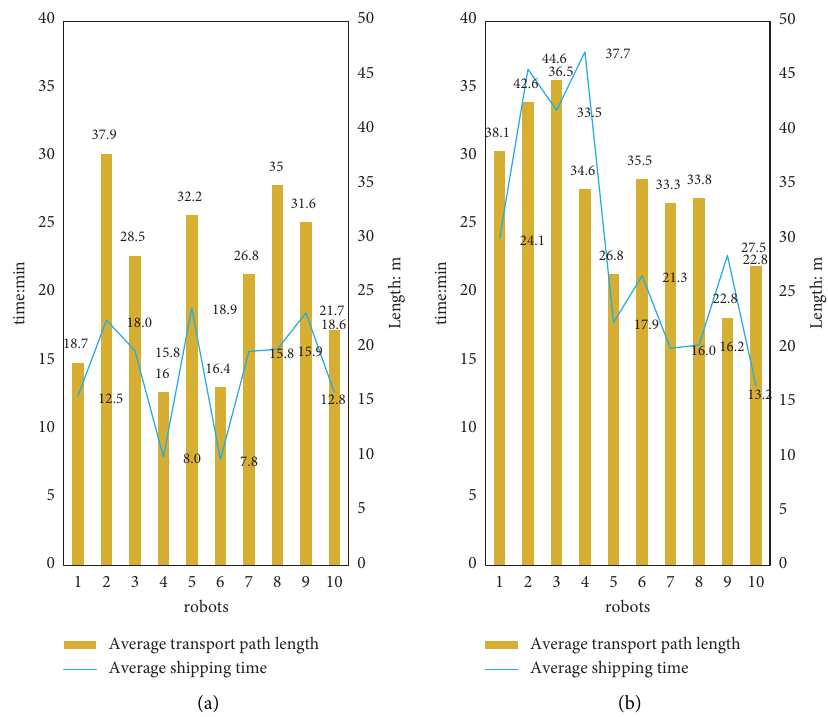
Figure 3: Transport path comparison. (a) Te frst set of experiments. (b) Te second set of experiments.